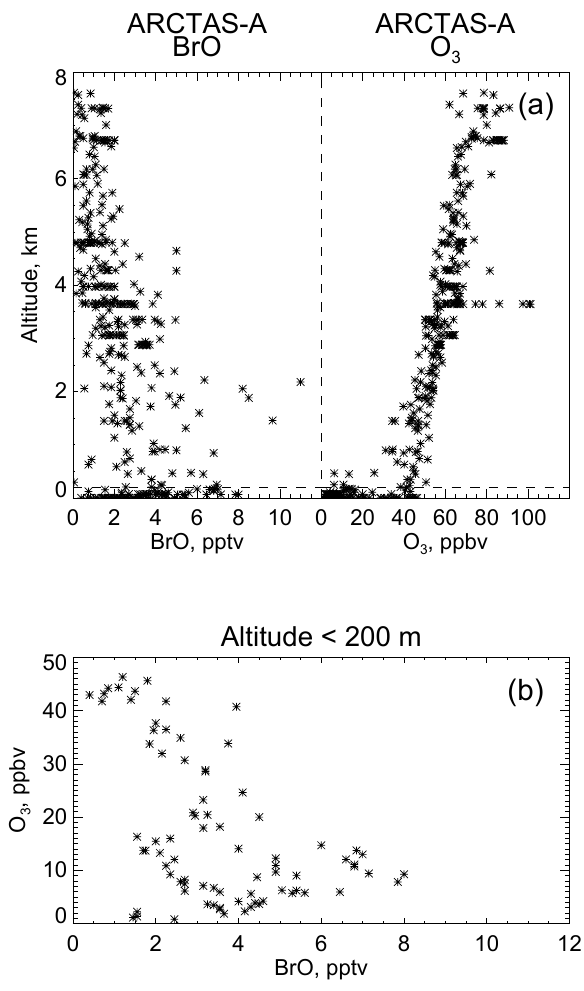
Fig. 13. Observations of BrO and O 3 during ARCTAS-A. Panel (a) shows observed altitude profiles of BrO and O 3 and (b) shows the correlation between BrO and O 3 in the lowest